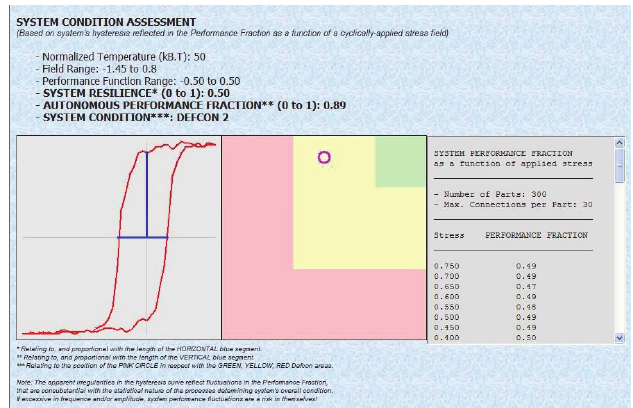
Figure 4. Hysteresis in a 300-part, 30-part links/part system, at a normalized temperature of 50 units: DEFCON 2.